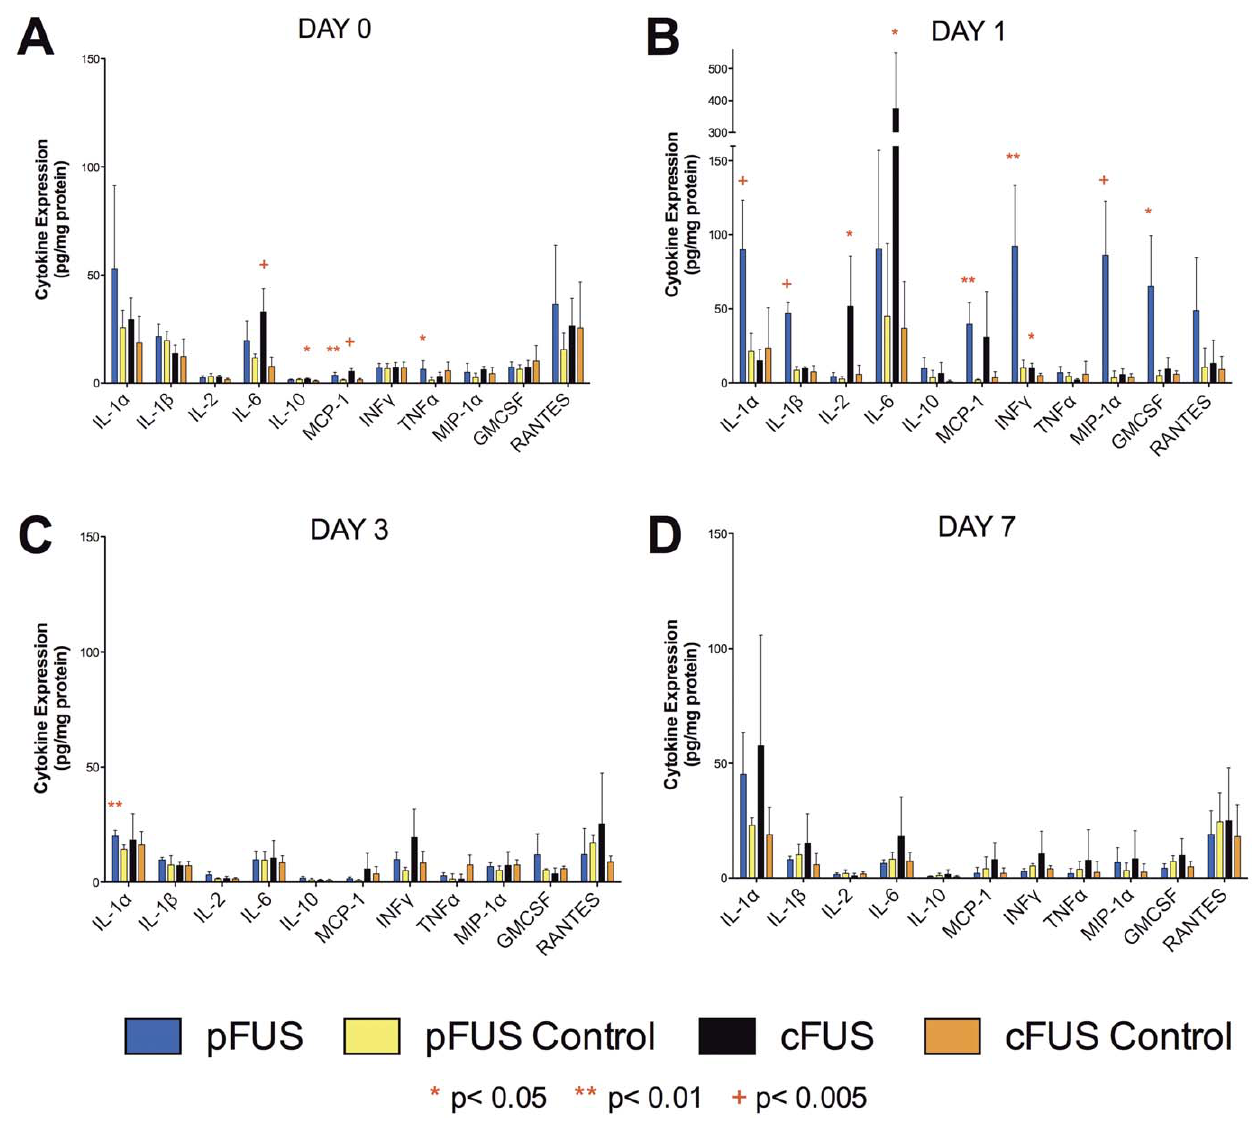
Figure 7. Expression of proinflammatory cytokines in muscle following cFUS or pFUS. Levels of each cytokine in muscle treated with cFUS or pFUS (n=5) was compared to the control tissue of the same day. Most cytokine elevations were short-lived and returned to control levels by day 3.